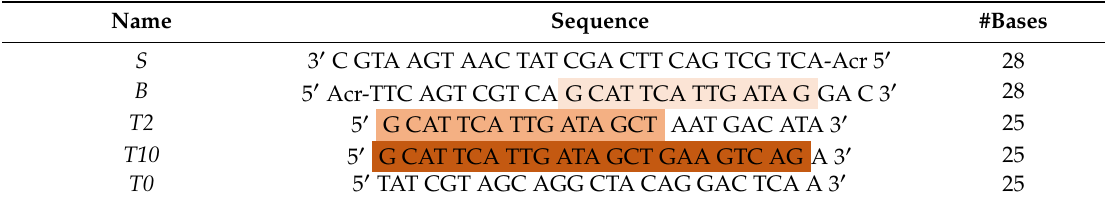
Table 1. Oligonucleotide sequences of the sensing, blocking, and target strands, with the position of acrydite groups (Acr) shown and the nucleobases complementary with sensing strand highlighted. Each sequence was realized both as Morpholino oligonucleotide (MO) and DNA